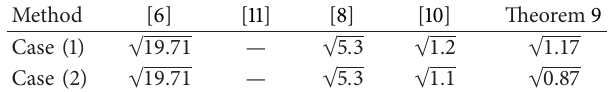
Table 5: Computed radiuses 𝑟 ’s of Example